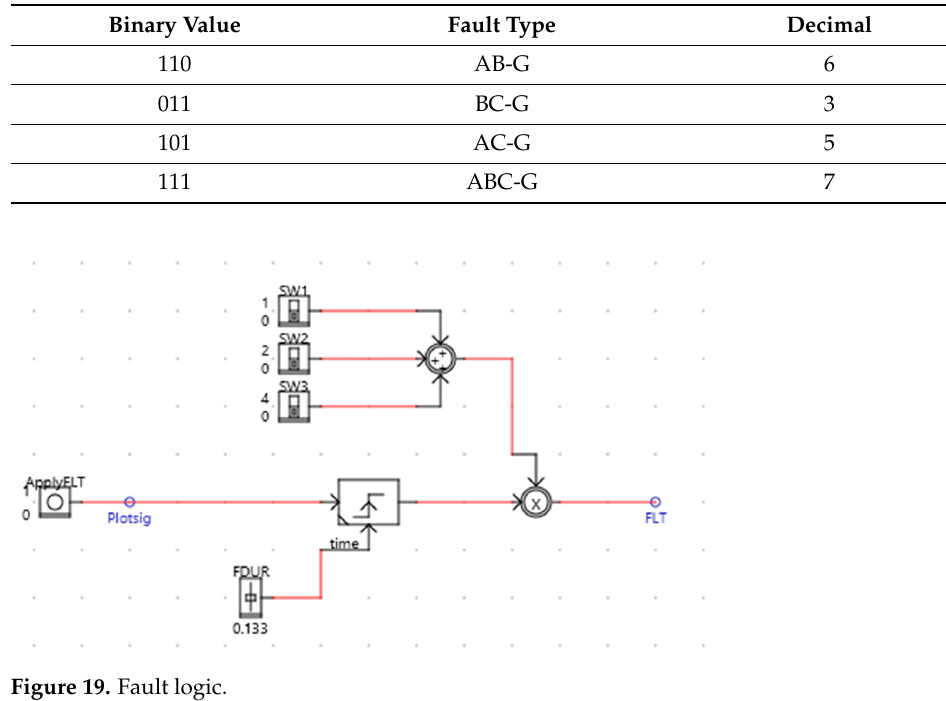
Table 4. Selecting fault type in RTDS. Table 4. Cont.